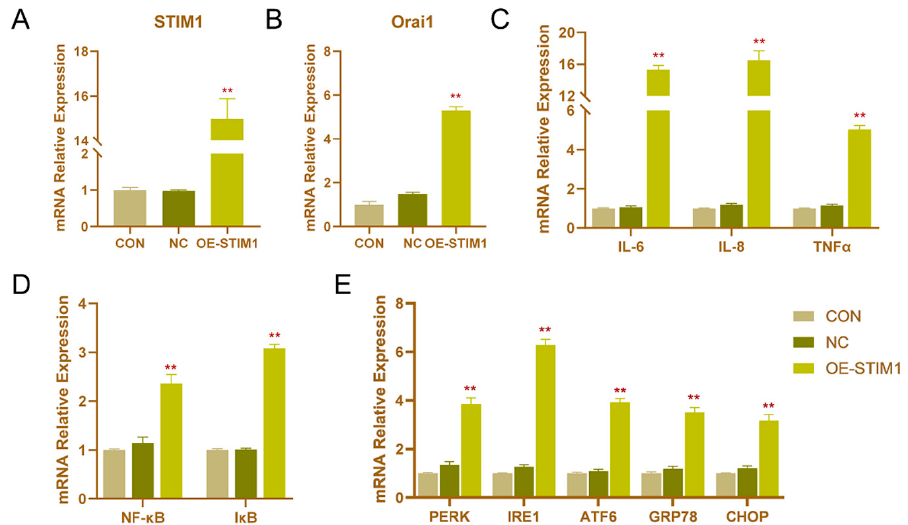
Figure 3. Effects of the overexpression of STIM1 on inflammation and endoplasmic reticulum stress (ERS) in BHEC. Treatments: BHEC were transfected with overexpressed plasmids and cultured for 48 h. CON, complete control groups; NC, transfected blank plasmid and cultured for 48 h; OE-STIM1, BHEC transfected with overexpressed STIM1 plasmid cultured for 48 h. All groups were cultured without LPS. (A,B) Expression of ( A ) STIM1 and ( B ) Orai1 in BHECs. ( C , D ) Expression of ( C ) IL-6, IL-8, and TNF- α , and ( D ) NF- κ B and I κ B associated with the inflammatory response. ( E ) Expression levels of ERS-related genes (PERK, IRE1, ATF6, GRP78, and CHOP) in BHEC. Gene expression was normalized to the expression of GAPDH. The results are presented as the means ± SEM., ** p < 0.01.